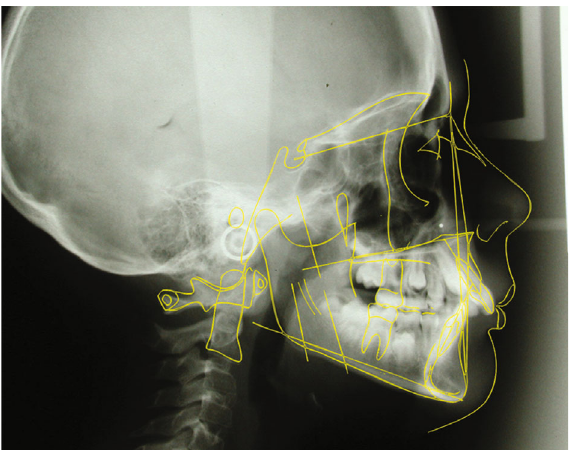
Figure 3: Initial lateral